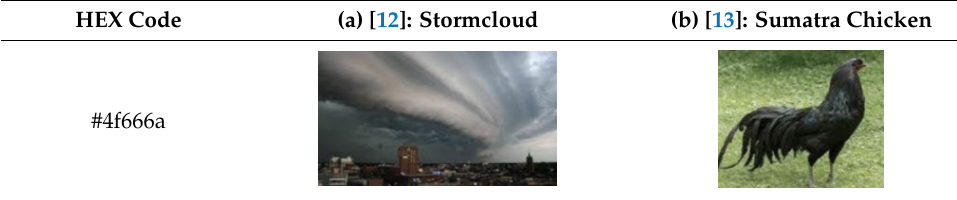
Table 1. Descriptions of the color name for the same color are different.